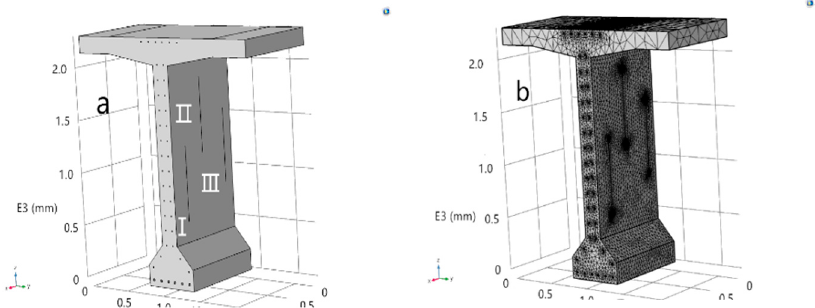
Figure 2. Sketch map of T-beam.